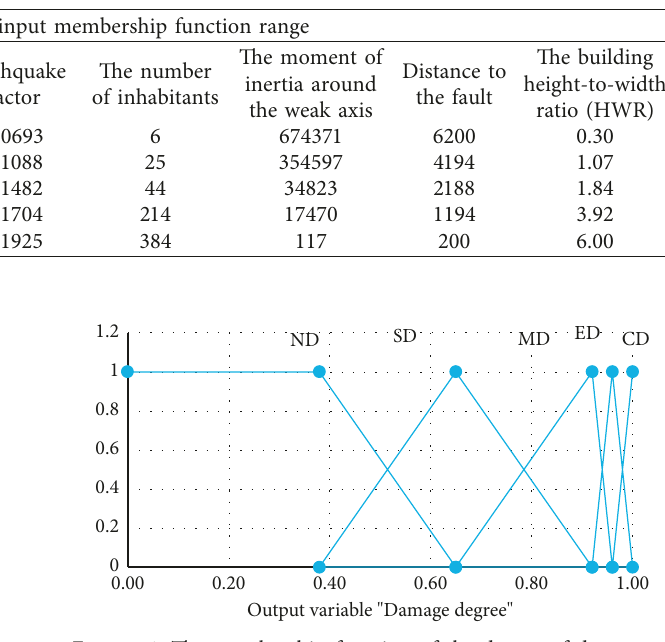
Figure 3: The membership function of the degree of damage to steel structures.